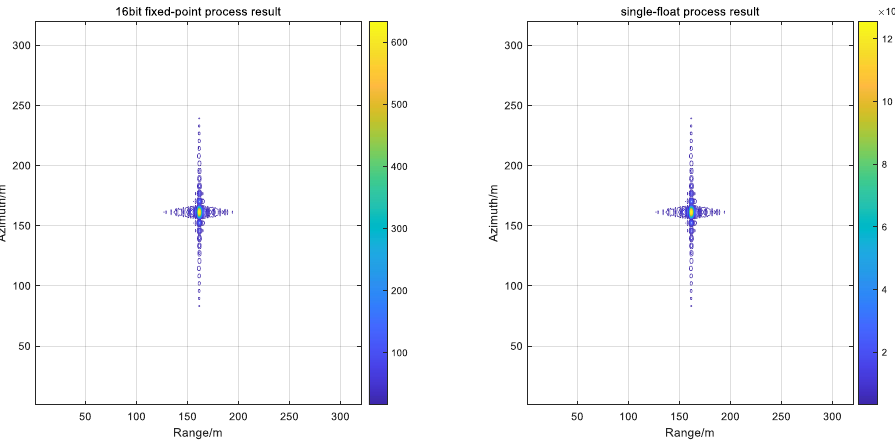
Figure 9. Bit-wise 16 bit vs. single-precision processing results.